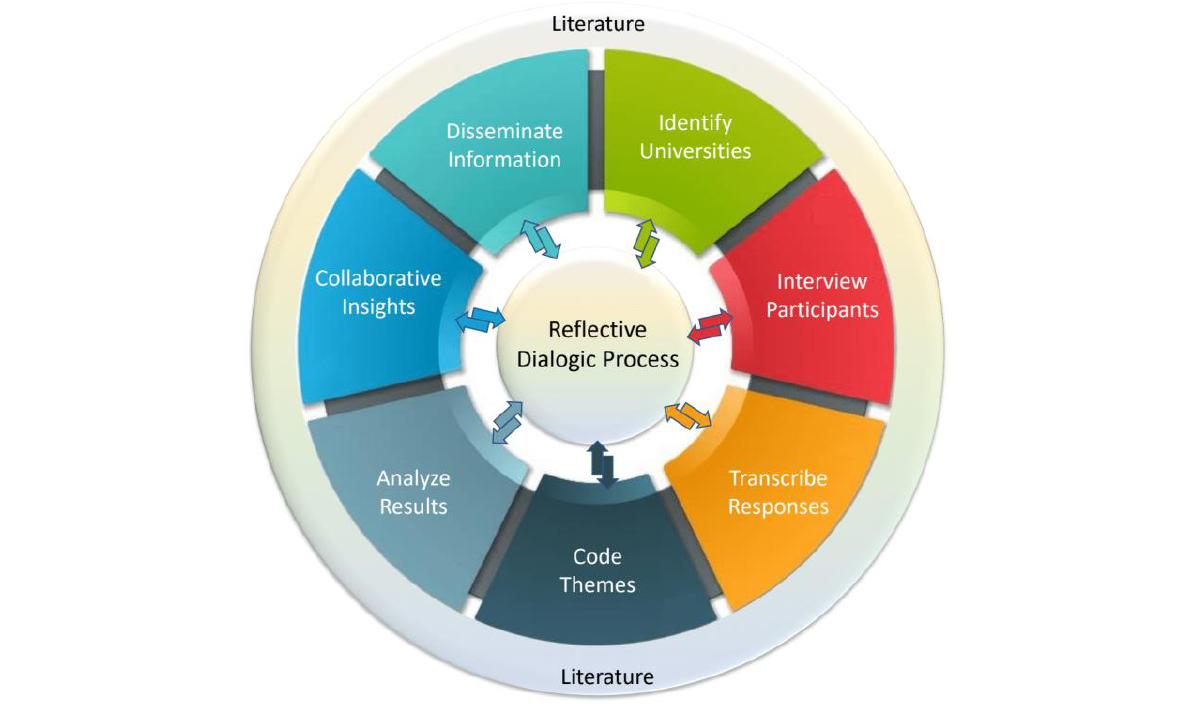
Figure 2: Our research